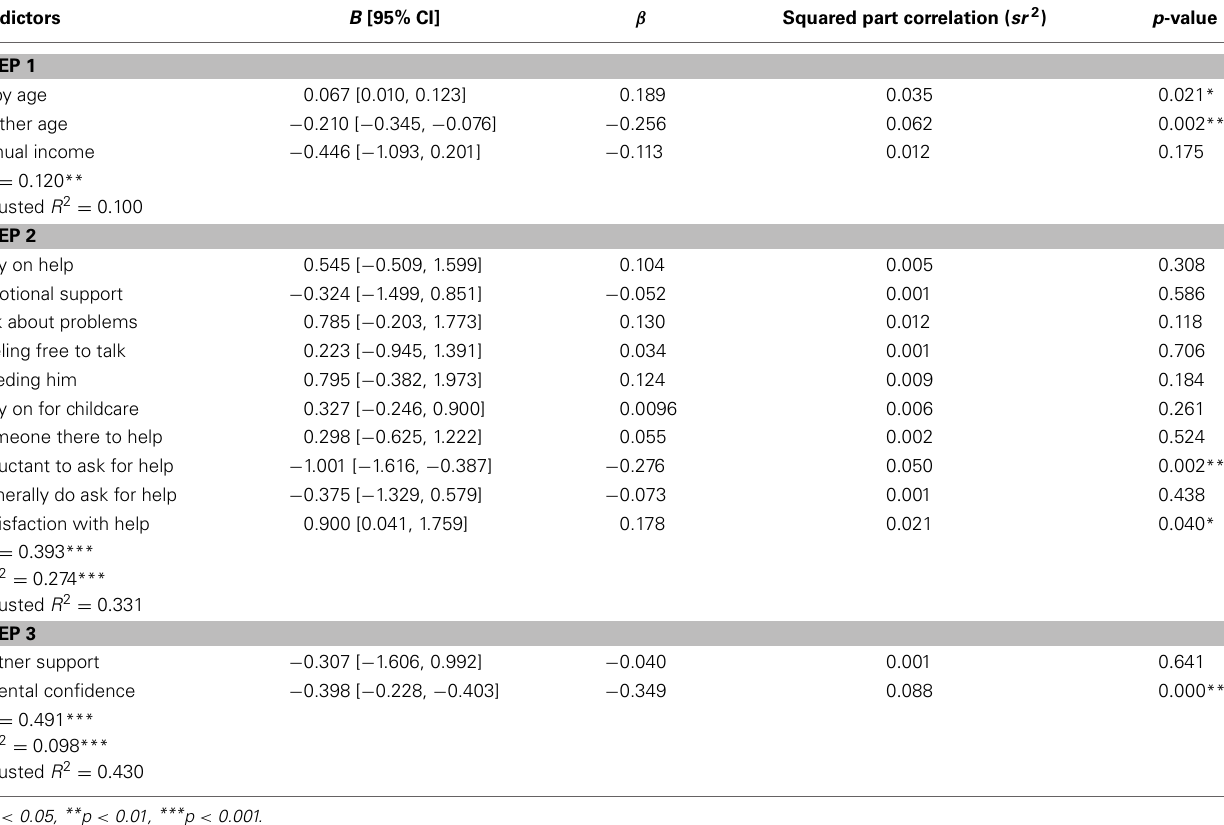
Table 2 | Hierarchical multiple regression analysis predicting postnatal depression from socio-demographic, social support, and parenting variables ( N = 140).